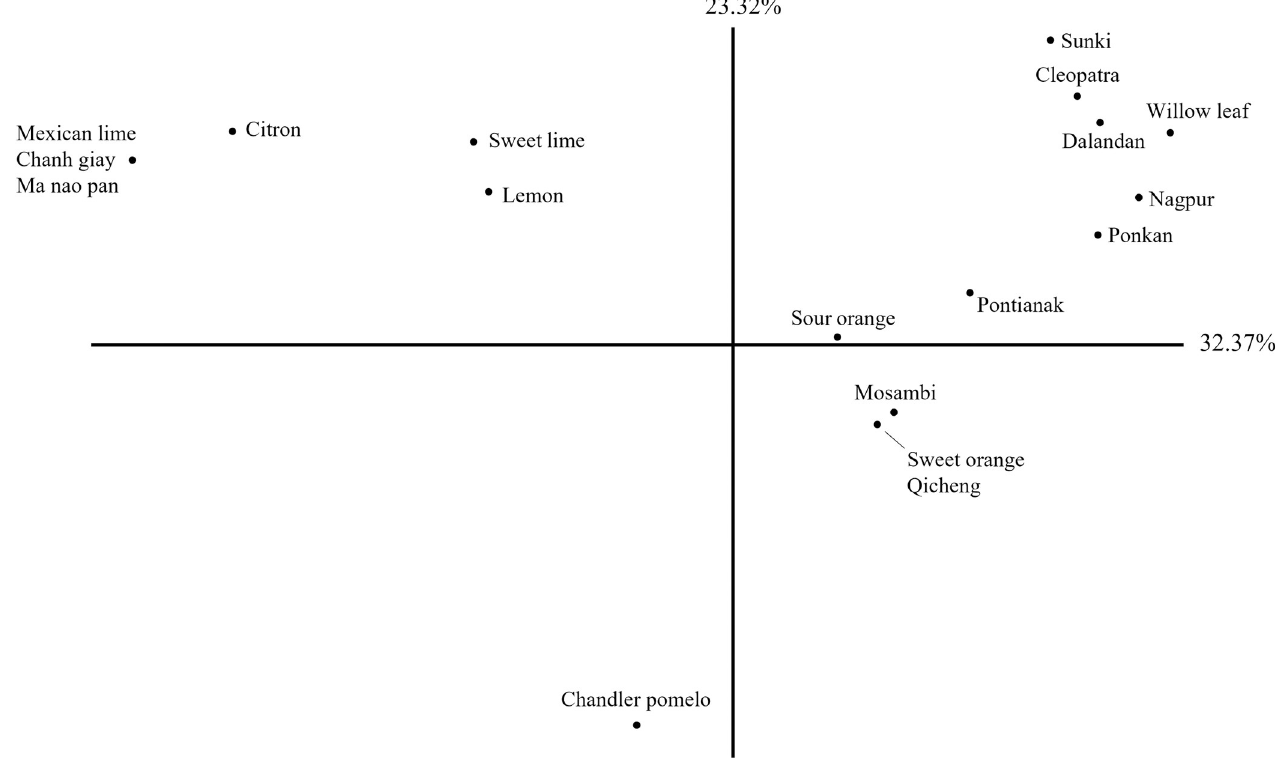
Fig 2. Factor analysis on genetic distance based on 16 SSR markers (S2(a) Table) of the seven Asian citrus varieties and their related accessions.